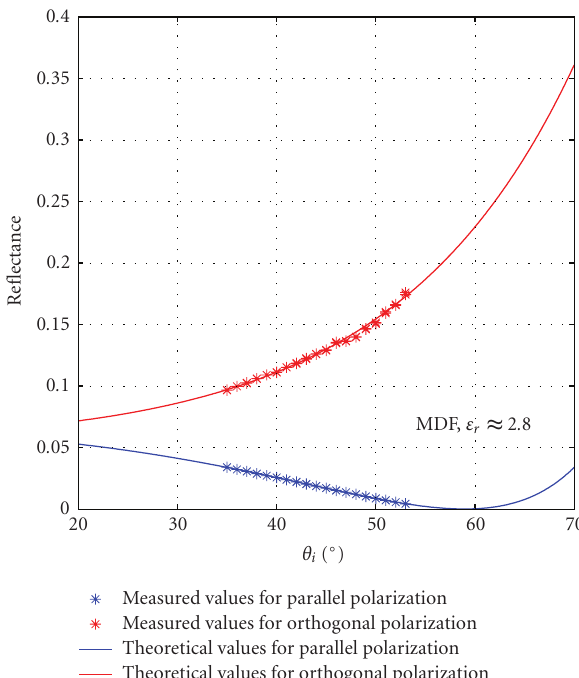
Figure 1: Measured and theoretical reflectance factors for an MDF- plate.